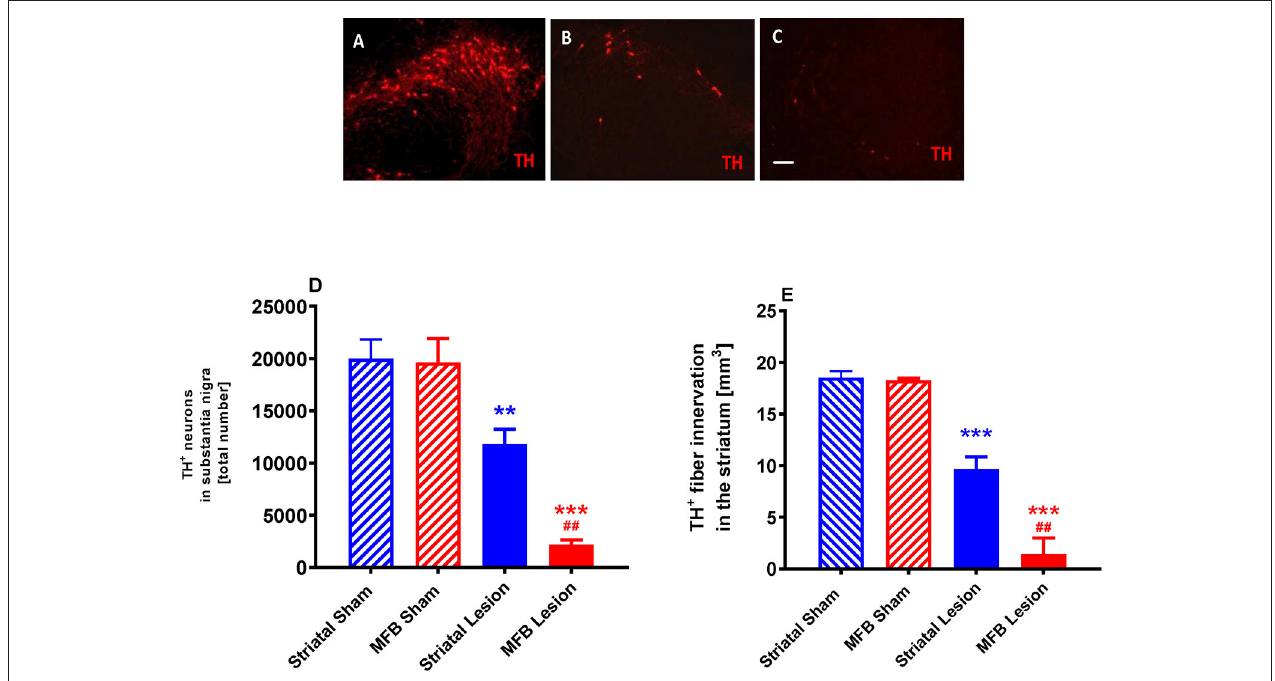
FIGURE 9 | Quantification of dopaminergic neuronal degeneration following 6-OHDA lesioning. Representative pictures of TH-positive neurons in the SNc in (A) sham animals, (B) striatal lesion group (B,C) MFB lesion group. Quantification of (D) TH-positive neurons in the SNc and (E) level of TH immunoreactivity in the striatum (E) . Data shown as mean ± s.e.m. *Indicates a significant difference on the lesion group when compared to its control (blue for striatal cohort and red for MBF cohort) and # indicates differences of MFB lesion vs. striatal lesion animals. ** P < 0.01; *** P < 0.001 (one-way ANOVA with Tukey’s or Dunnett’s post-hoc